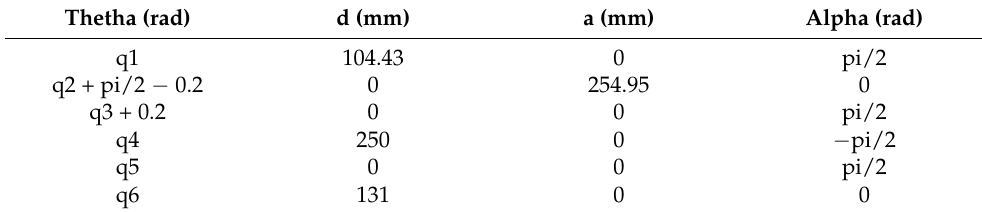
Table 3. 6DOF Manipulator’s